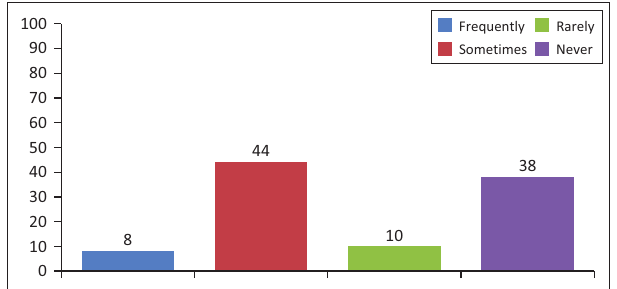
FIGURE 1: Responses of participants on condom usage.